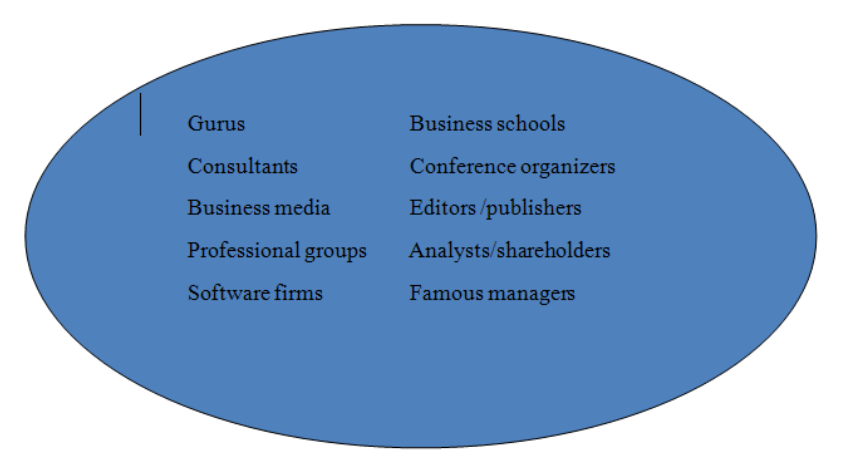
Figure 1. The management fashion arena (adapted from [2,26,27]).